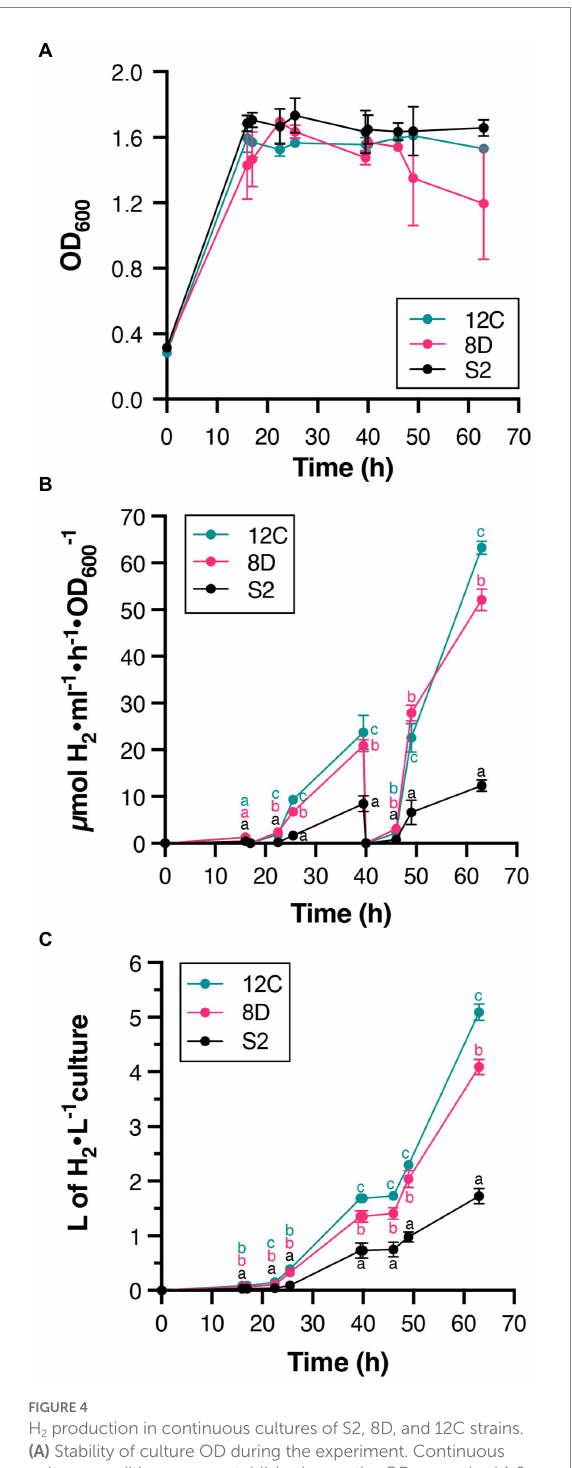
FIGURE 4 H 2 production in continuous cultures of S2, 8D, and 12C strains.